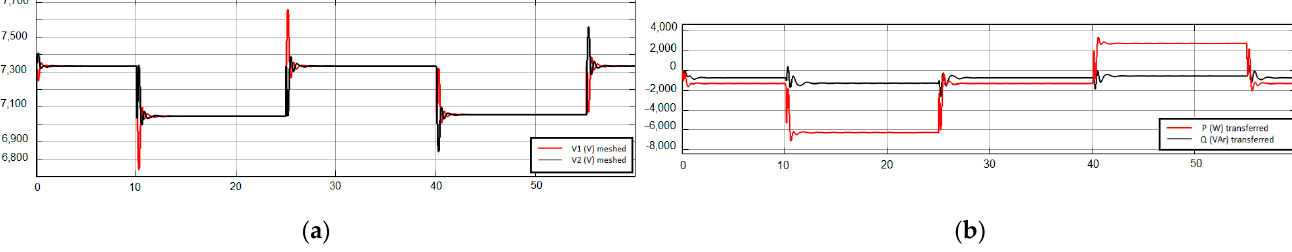
Figure 13. Simulation results with the series VSC operation; ( a ) V 1 and V 2 ; ( b ) transferred P and Q.